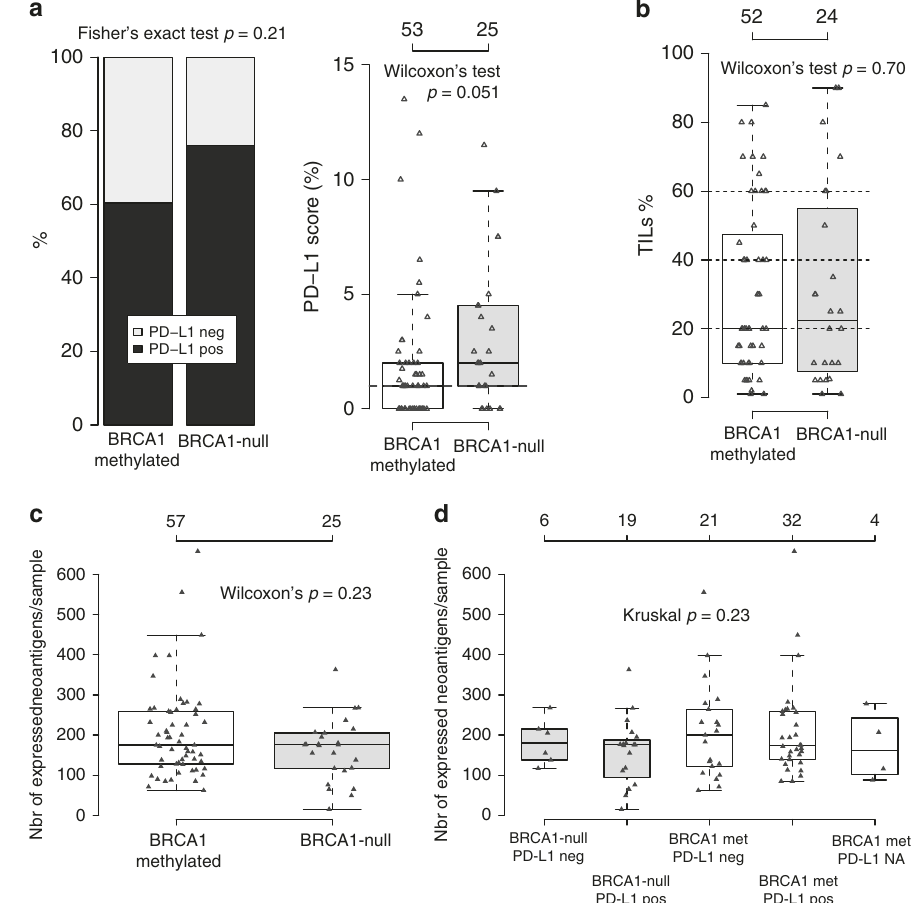
Fig. 6 Immune cell in fi ltration phenotypes in BRCA1 -null and hypermethylated cases. a PD-L1 scoring of 53 BRCA1 hypermethylated and 25 BRCA1 -null SCAN-B cases using the Roche SP-142 antibody that is evaluated in immune cells. To the left, proportion of positive cases ( ≥ 1%), to the right distribution of actual PD-L1 scores for the two groups. b Scoring of tumor in fi ltrating lymphocytes (TILs) in 52 BRCA1 hypermethylated and 24 BRCA1 -null SCAN-B cases based on available whole section H&E slides. c Total number of expressed neoantigens per sample as calculated from substitutions by NeoPredPipe 36 for BRCA1 -null and BRCA1 hypermethylated SCAN-B cases. d Neoantigens as shown in ( c ), but strati fi ed for sample groups also by PD-L1 IHC status. Four hypermethylated cases did not have available PD-L1 immunohistochemistry data. All p values reported from statistical tests are two-sided. Source data